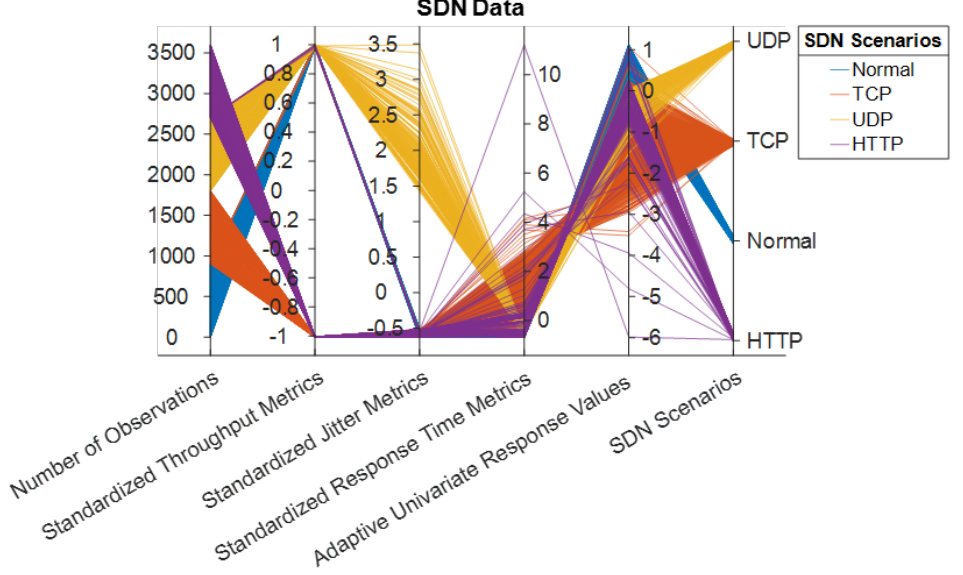
Figure 7. Parallel coordinates of the zero scores of T p , J t and R t metrics for all the SDN scenarios.